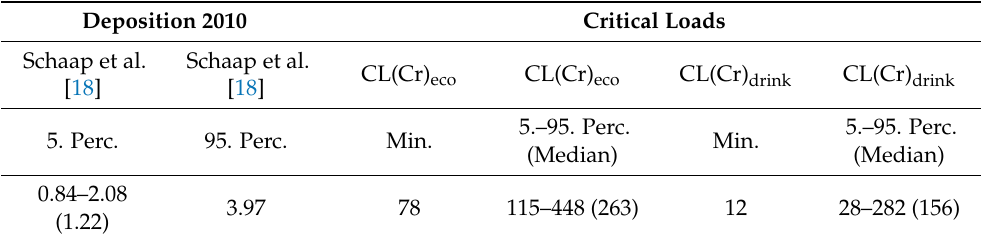
Table 12. Comparison of Cr deposition 2010 (in g ha − 1 a − 1 ) and critical loads (in g ha − 1 a − 1 ) of receptor areas in